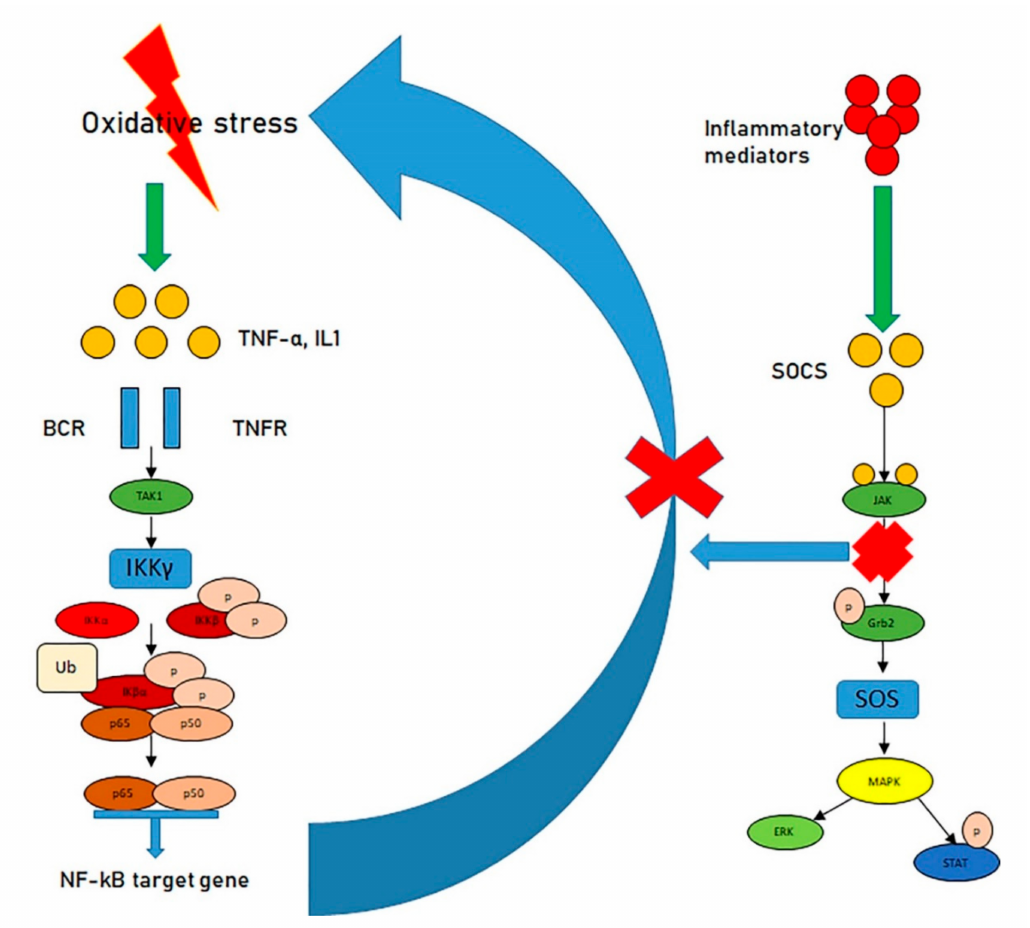
Figure 2. Oxidative stress, the NF- κ B pathway, and the JAK–STAT pathway. Oxidative stress stimulates the NF- κ B pathway, fostering a cycle in which oxidative stress generates ROS, which, in turn, produces more oxidative stress ( left ). However, inflammatory mediators stimulate the Suppressors of cytokine signaling (SOCS), in turn linking to JAKs, interrupting the JAK–STAT pathway ( right ) and, ultimately, blocking the inflammatory